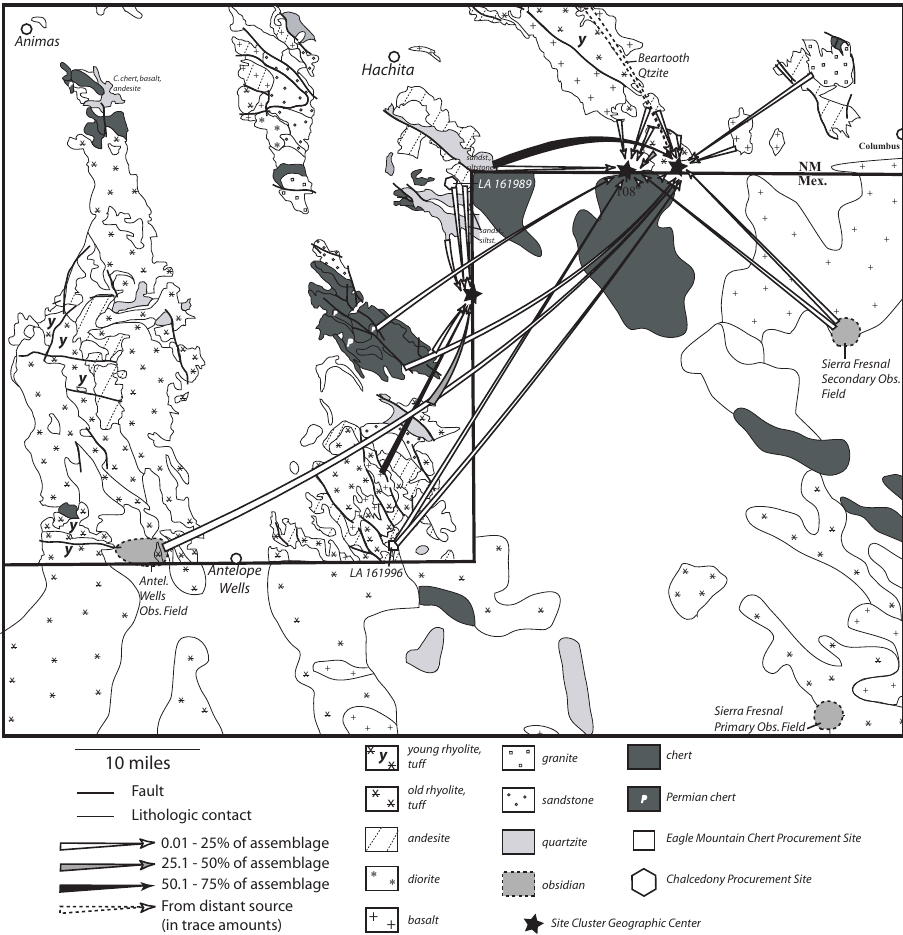
Fig. 7. Geologic map of the Boot Heel of southwestern New Mexico with locations of site clusters and minimum distance movement of geologic materials for sites identified as